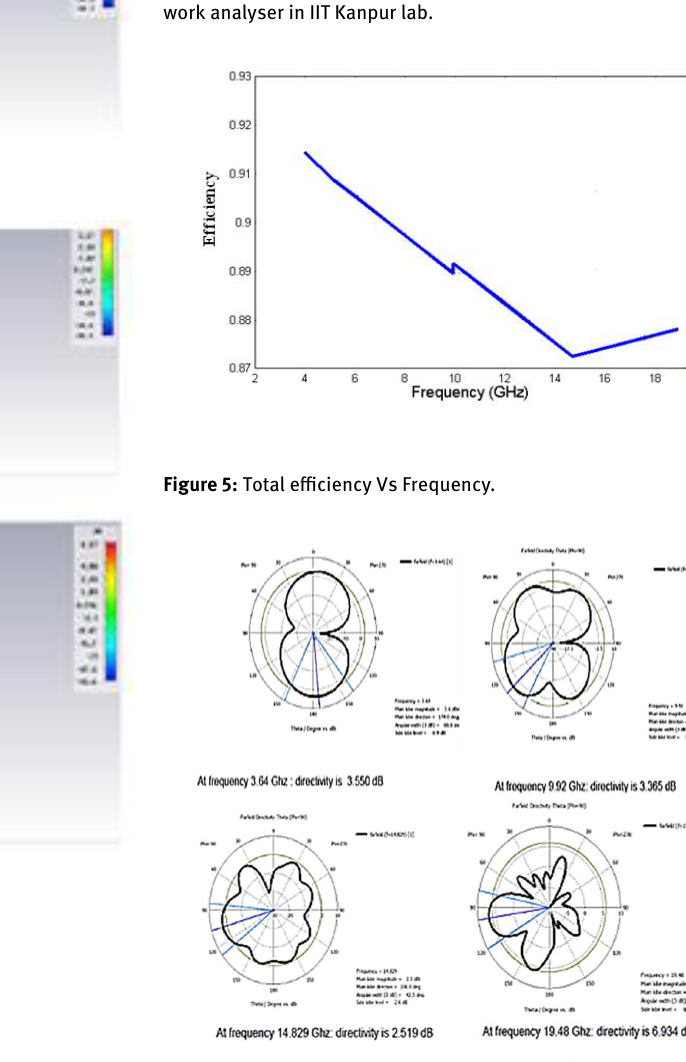
Figure 4: Proposed antenna while measuring results on vector net- work analyser in IIT Kanpur lab.